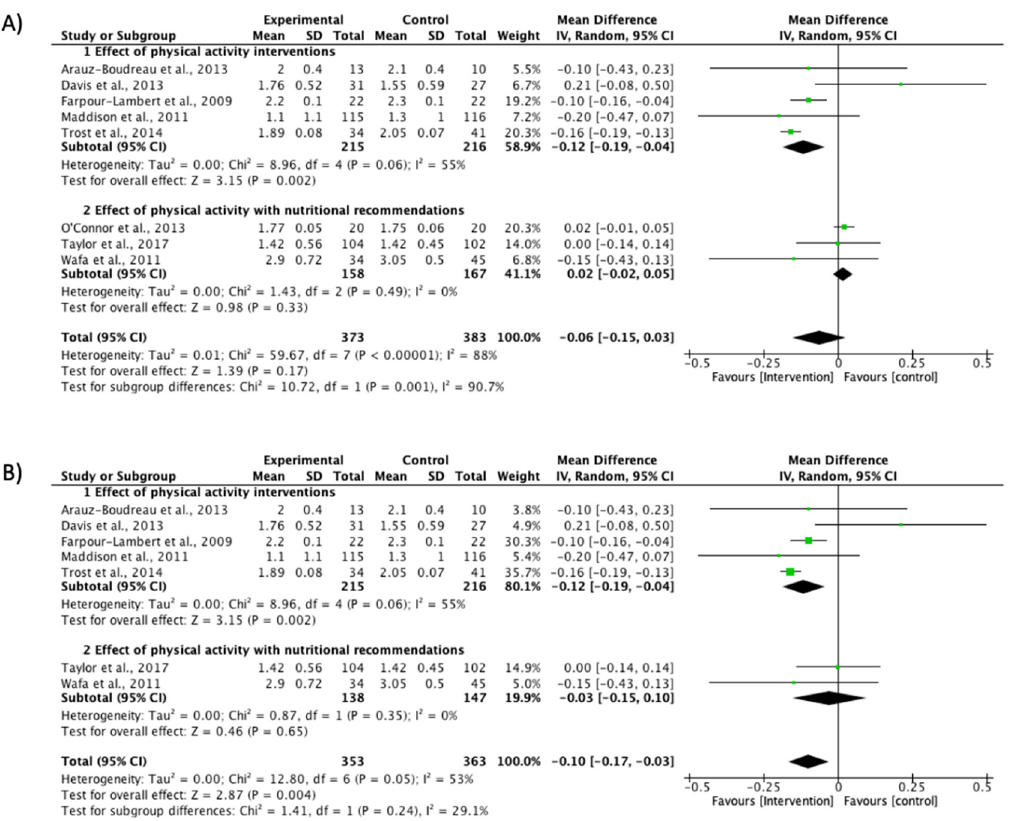
Figure 2. Effect interventions on BMI Z-score reduction. ( A ) BMI Z-score values forest plot. ( B ) Sensitivity analysis of BMI Z-score forest plot (O’Connor et al. study [32] not included). CI, confidence interval.